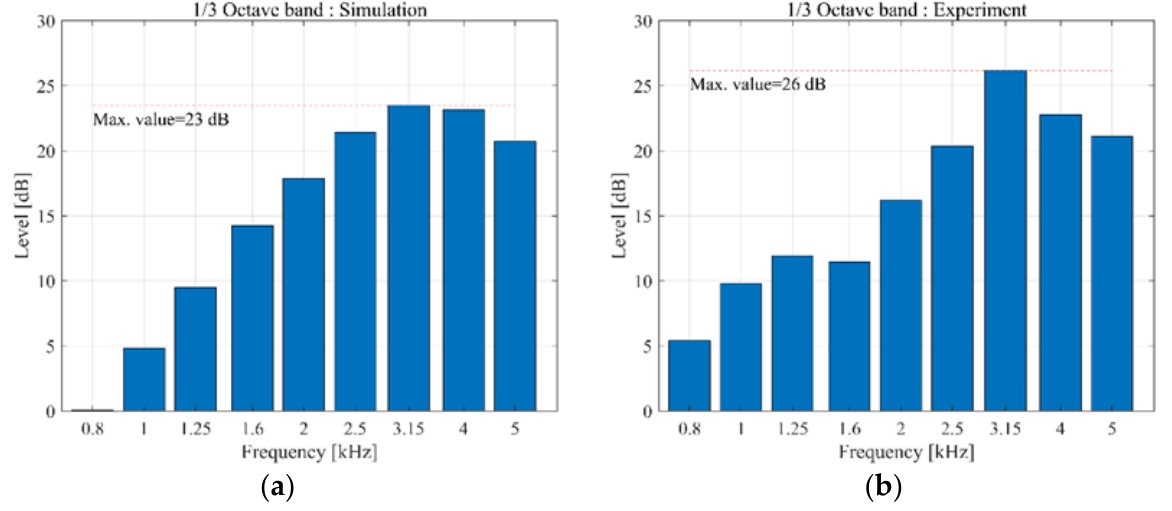
Figure 8. Sound pressure level for the standard model: ( a ) simulation results and ( b ) experimental results.